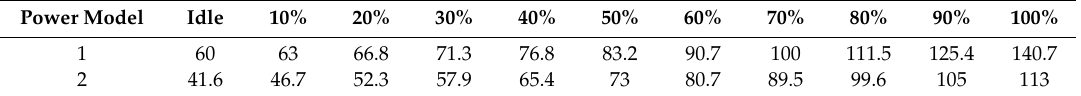
Table 2. Power (in watts) model of physical machines (PMs) [24].